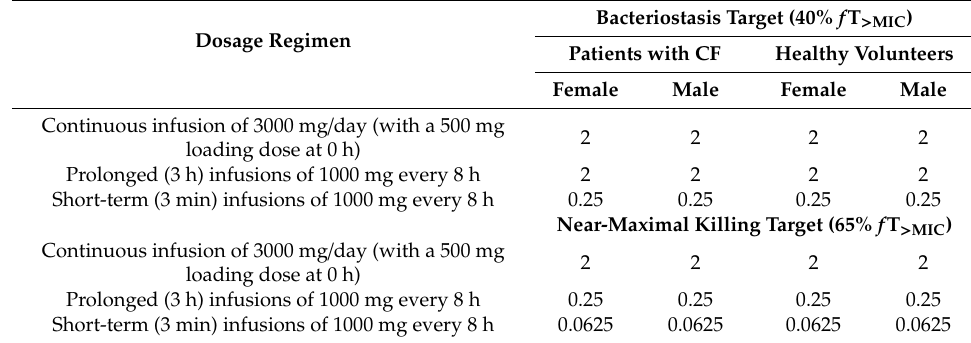
Continuous infusion of 3000 mg / day (with a 500 mg loading dose at 0